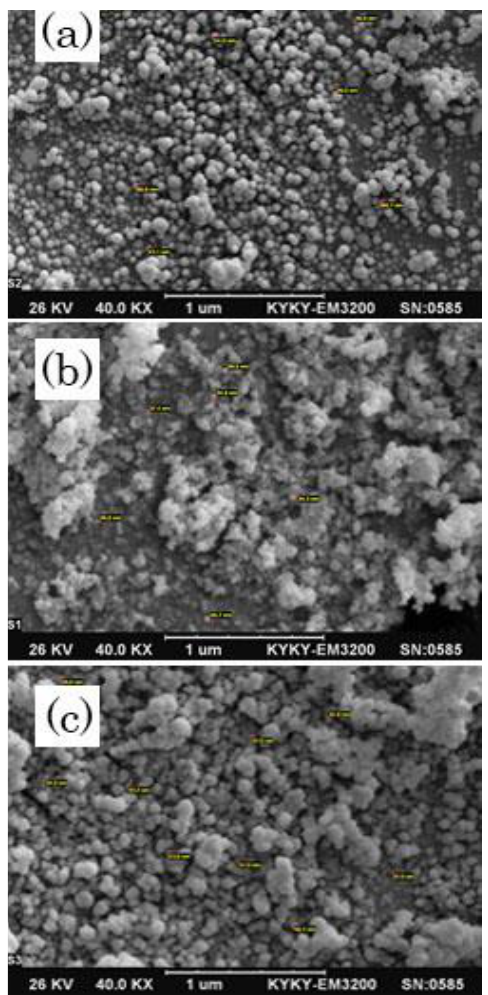
O nanosorbents 3 4